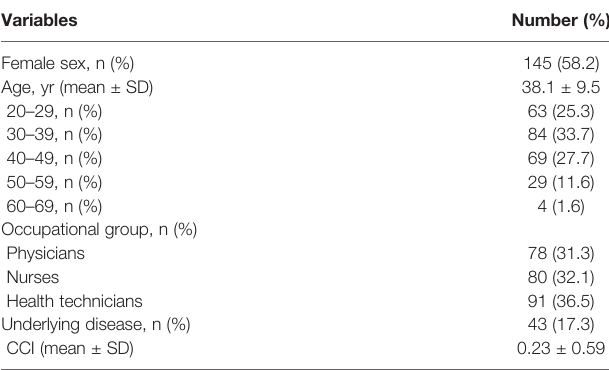
TABLE 1 | Demographic characteristics of the study participants (n =